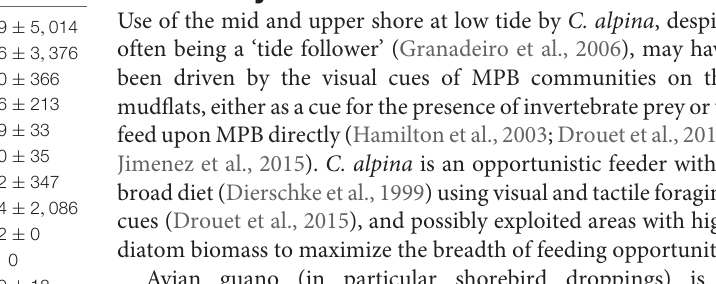
TABLE 4 | Count of each macrofauna species recorded within each core extracted from the study area on Day 45 (06 March 2017) on the mudflat adjacent to Geedon Saltings at Fingringhoe Wick Essex Wildlife Trust Nature Reserve, Essex, United Kingdom (grid reference TM 05065 19030). Species/Family Treatment (shorebirds present = P, shorebirds absent =